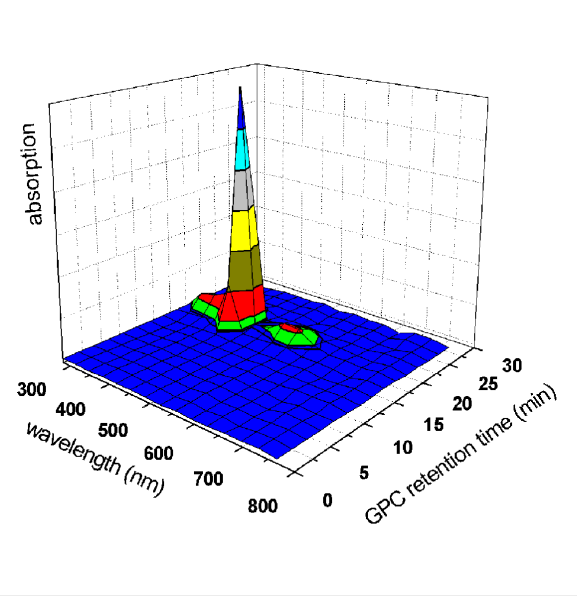
Figure 10: SEC spectrum obtained for star-pEtOx utilizing a photo- diode-array detector (eluent: DMF containing 5 mM NH 4 PF 6 ).